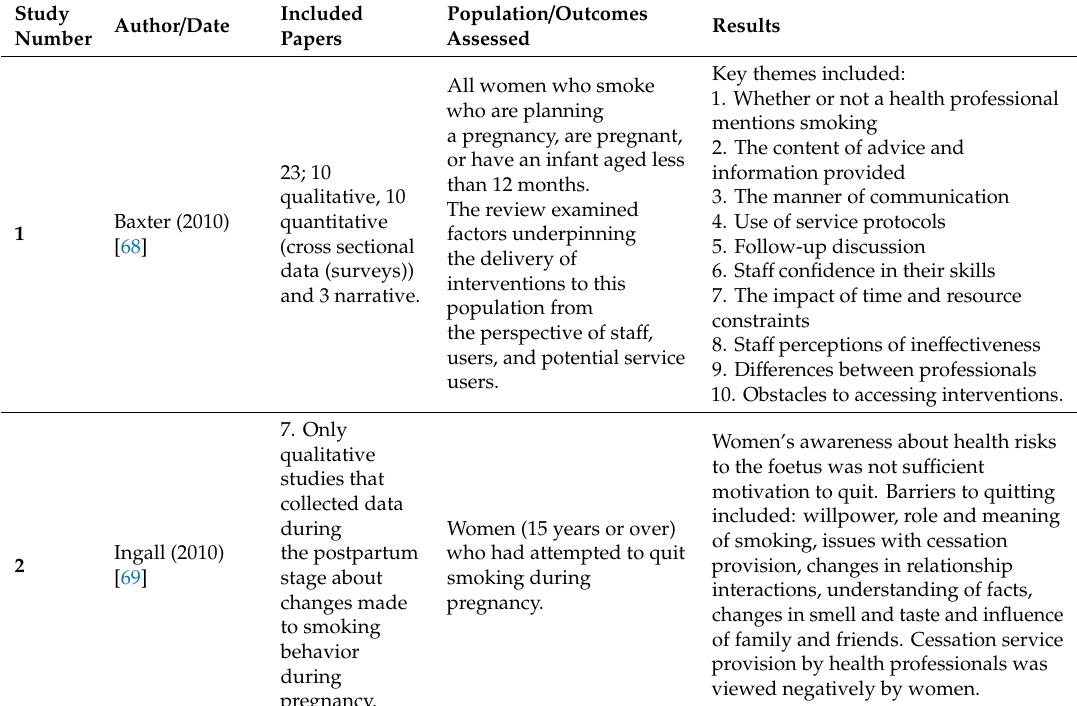
Table 5. Barriers and predictors of smoking cessation among pregnant